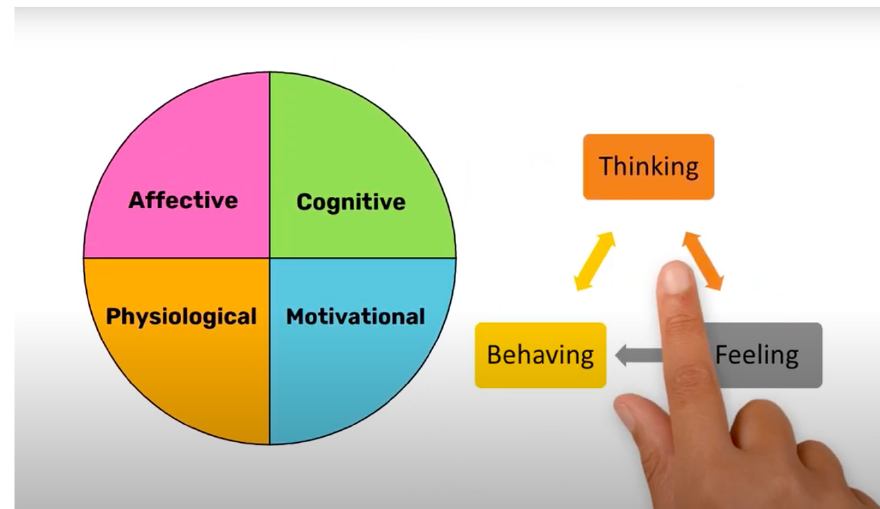
Figure 1. Thinking-feeling-behaving sequence of boredom. Note. The illustration is a screenshot from the boredom intervention training (BIT) video emphasizing the multidimensional components of boredom and the “thinking–feeling–behaving” sequence that triggers and maintains boredom.